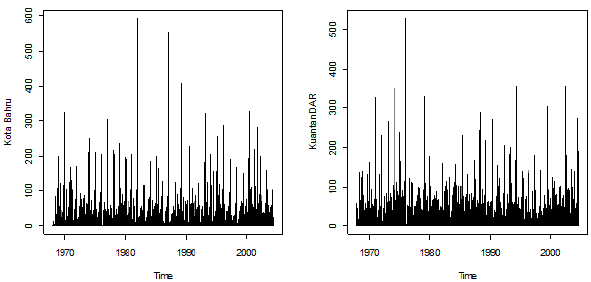
Fig. 1. Time series plots of daily rainfall series of Kota Bharu and Kuantan.